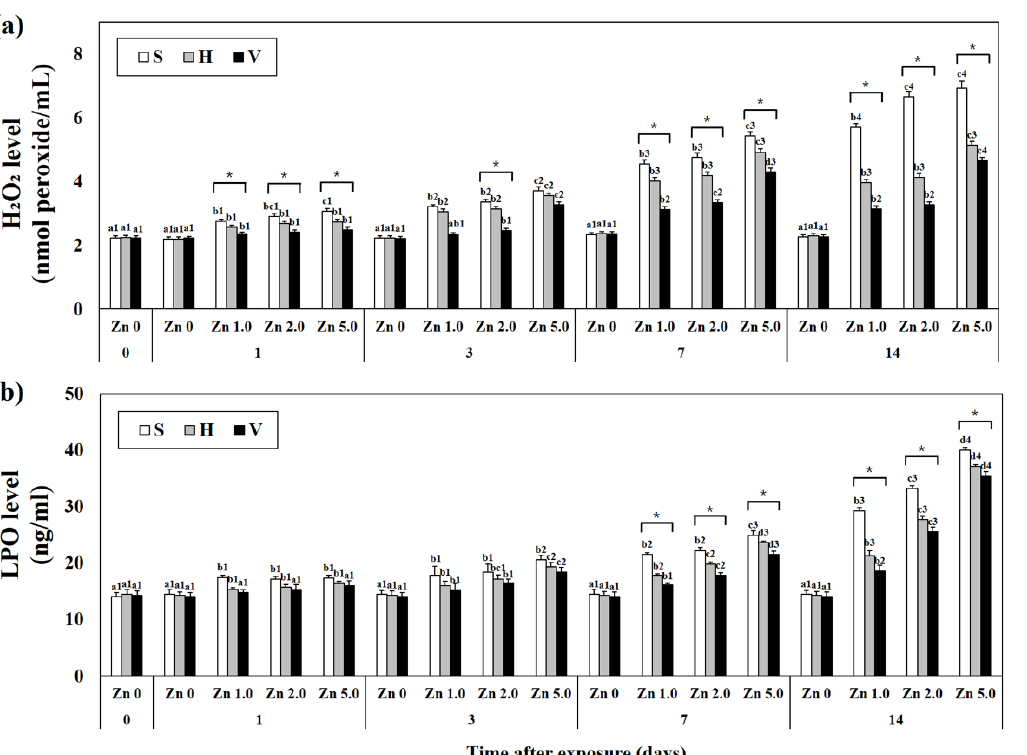
Figure 3. Concentration of ( a ) H 2 O 2 and ( b ) LPO in plasma of goldfish for 14 days. Different letters indicate significant differences among goldfish exposed to the same water hardness and different Zn concentration for same duration ( p < 0.05). Different numbers indicate significant differences among goldfish exposed to same Zn concentrations and water hardness for the different exposure time ( p < 0.05). “*” indicate s significant differences among goldfish exposed to different water hardness and same Zn concentration for same duration ( p < 0.05). “ * ” was marked when there were only significant differences in all combinations of the values of each S/H/V experimental group. Values indicate means ± SD ( n = 4).